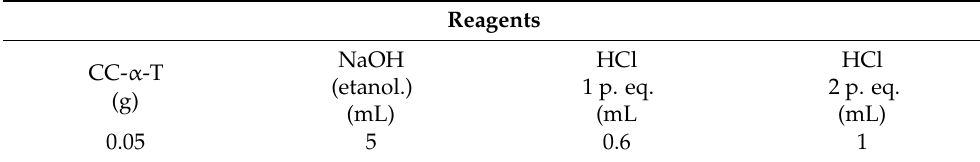
Table 2. Reagents used in the volumetric analysis of substitution